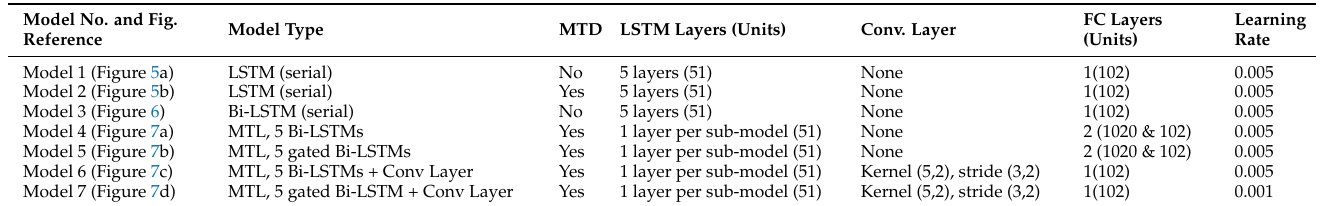
Table 3. Hyper-parameter selection for LSTM, Bi-LSTM, and other variants of the architecture. The MTD column is used for medical treatment data (included/not